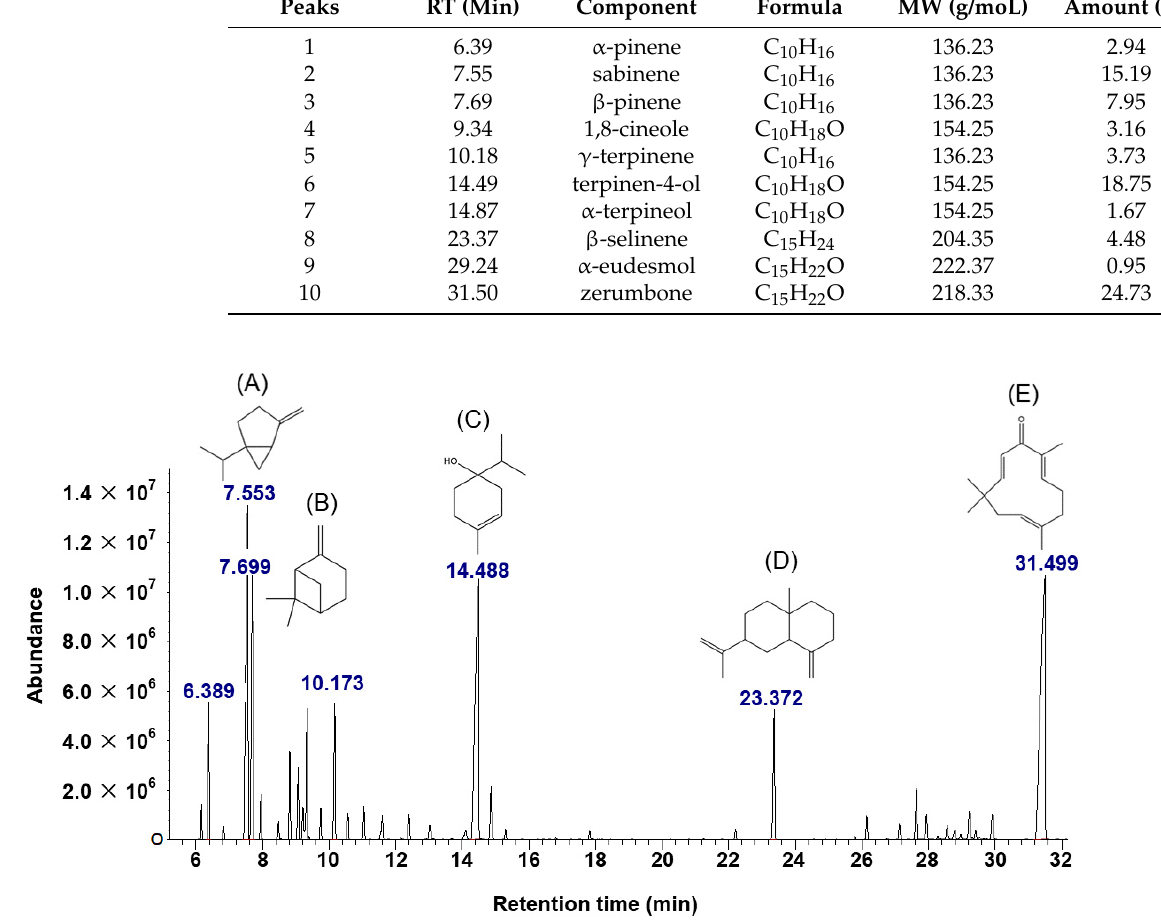
Figure 1. GC–MS chromatogram of ZO essential oil. Phytochemicals were identified by the GC–MS method. Chemical structures of the five major compounds from ZO essential oil included ( A ) sabinene, ( B ) β -pinene, ( C ) terpinen-4-ol, ( D ) β -selinene, and ( E ) zerumbone.